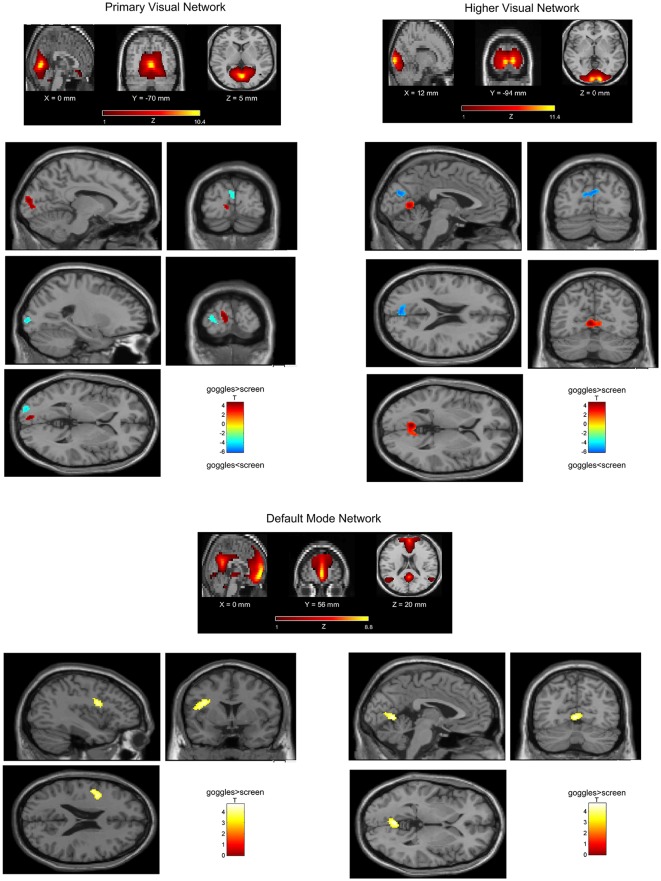
Network spatial maps and group differences: default mode network (DMN) and visual. In the primary visual network, there was an increase in connectivity (in red) in the left calcarine and in the higher visual network in the left lingual in the goggles (monoscopic + stereoscopic) condition as compared to the screen condition. A decreased in connectivity (in blue) was seen in the left middle occipital in the primary visual network and in the bilateral cuneus in the higher visual network. In the DMN, we found an increase (in yellow) in the connectivity in the inferior frontal and bilateral lingual for goggles (monoscopic + stereoscopic) as compared to screen condition.